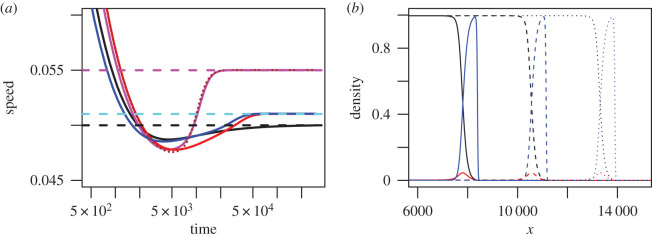
Strains that are outcompeted at equilibrium can still generate anomalous invasion speeds. Strains are numbered as in figure 1a, but competition coefficients are such that strain 3 outcompetes strains 2 and 4 at equilibrium (Cji = 0.8 for i = 3 and j = 2 or 4; Cji = 1.25 for j = 3 and i = 2 or 4). (a) Invasion speeds as a function of time. Colours denote different combinations of strains being present in the species: strains 2,3,4 with universal mutation (magenta); strains 2 and 4 (brown dotted); strains 2 and 3 (blue); strains 3 and 4 (red); strain 3 only (black). Dashed horizontal lines are theoretical predictions for μ → 0: c=c24d=0.055 (magenta); c=c23d=c34d=0.05103 (cyan); c=c3m=0,5 (black). (b) Population density as a function of spatial coordinate x, at times t = 105 (solid curves), 1.5 × 105 (dashed curves), 2 × 105 (dotted curves). In b, strains are coloured as in figure 1a. From numerical solutions of equation (2.1), with mutation μ = 10−6.